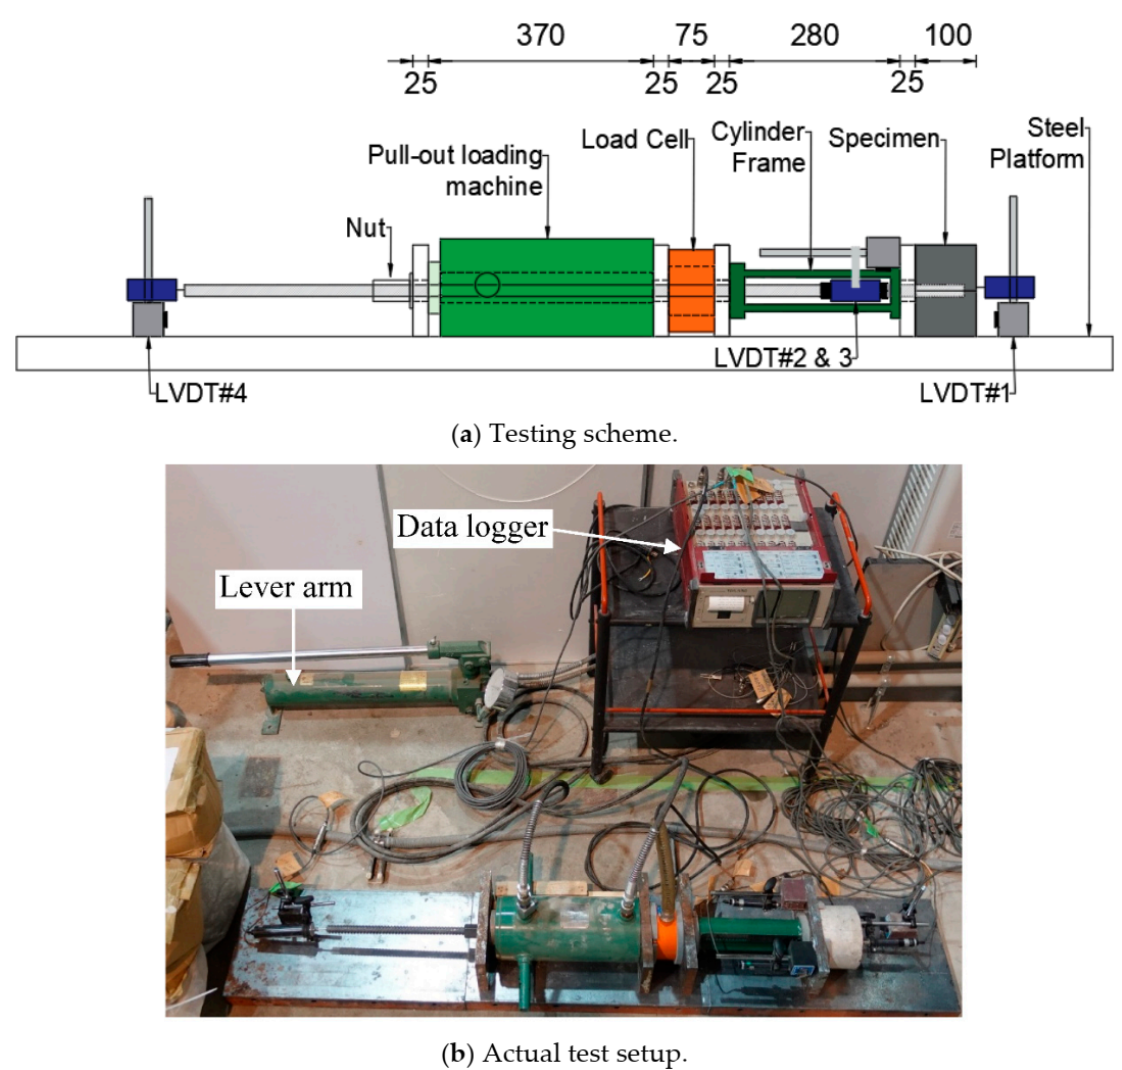
Figure 6. Pullout testing (dimensions in